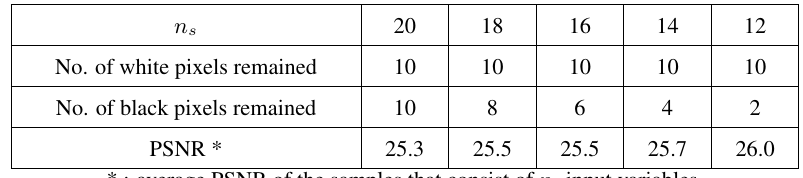
Figure 4. Sample distribution for various n data sample ( n = 20); (b) refined data sample ( n s